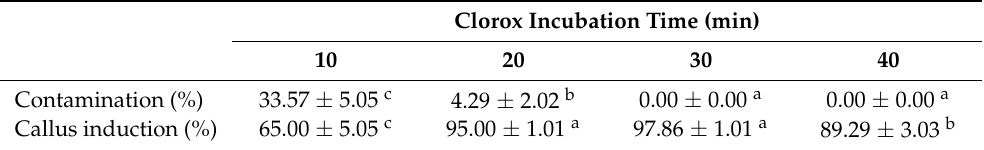
Table 2. Effect of Clorox incubation time on rice callus induction.